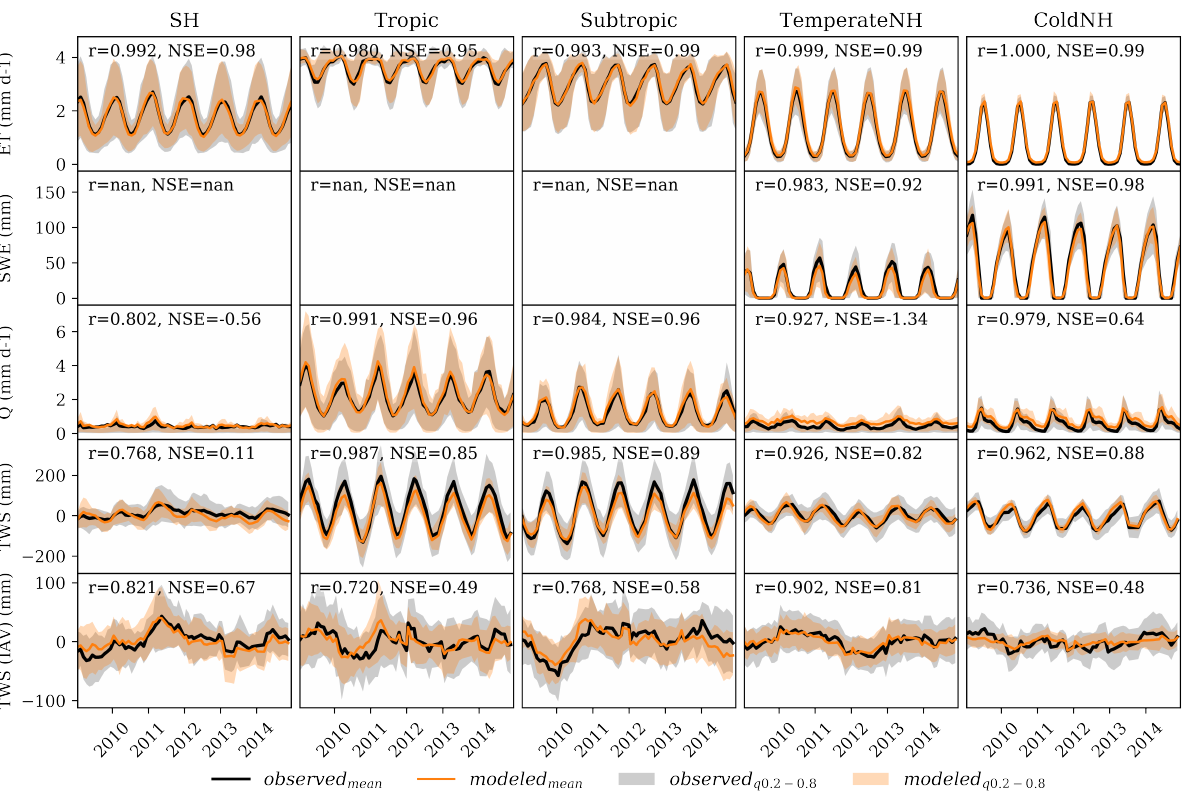
Figure 3. The model performance based on the test set by bioclimatic regions. The four target variables evapotranspiration (ET), snow water equivalent (SWE), runoff (Q), total water storage (TWS), as well as the TWS interannual variability (IAV) are shown. The TWS IAV is calculated as the deviation from the mean seasonal cycle, for observations and the predictions independently. The shaded areas indicate the 0 . 2 − 0 . 8 quantiles of the spatial variablity. For each region and variable, the Pearson correlation coefficient (r) and the Nash–Sutcliffe model efficiency coefficient (NSE) are